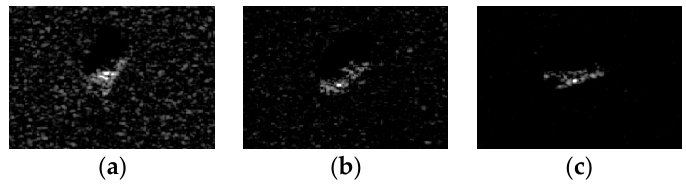
Figure 8. ( a ) BMP2 original SAR image. ( b ) BTR70 original SAR image. ( c ) T72 original SAR image.